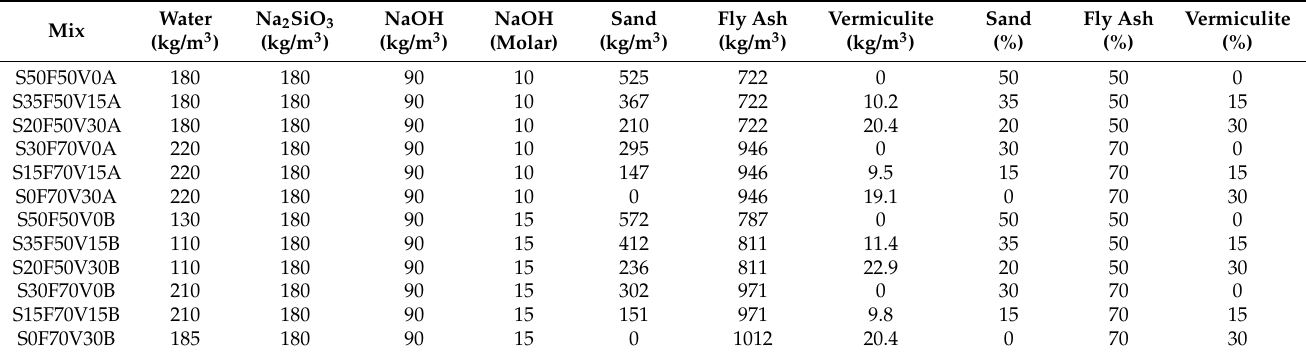
Table 4. Mix proportions of geopolymer